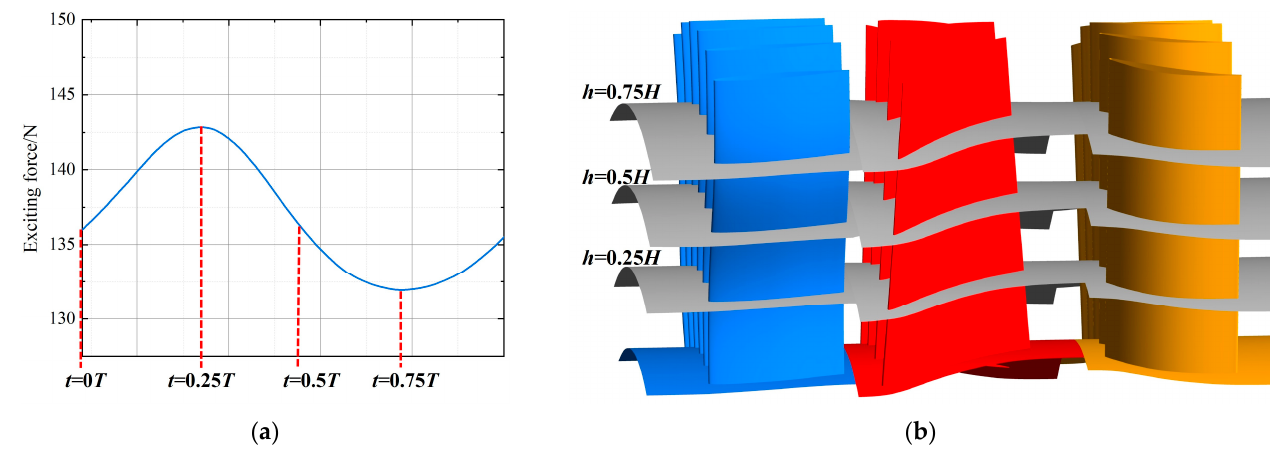
Figure 11. Selection of location and time of unsteady flow field. ( a ) Time selection; ( b ) Blade–height location selection. The blue parts show the guide vanes, the red parts show the moving vanes, and the yellow parts show the stator vanes.